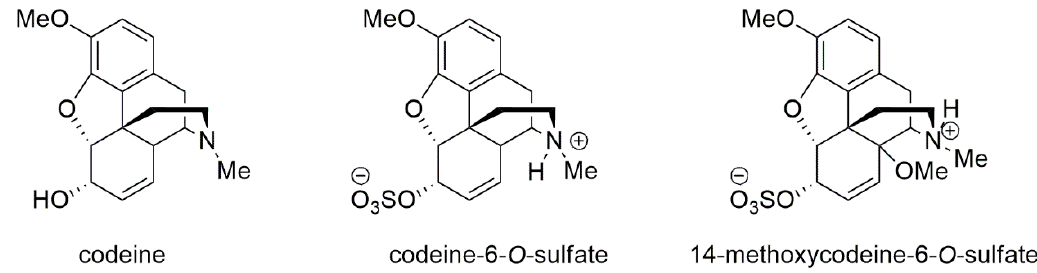
Figure 1. The structure of codeine, codeine-6- O -sulfate and 14-methoxycodeine-6- O -sulfate.